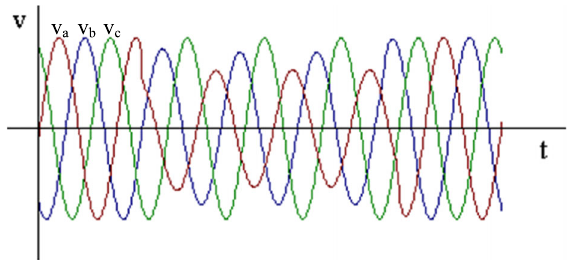
Fig. 4 Three phase voltages during Unbalance